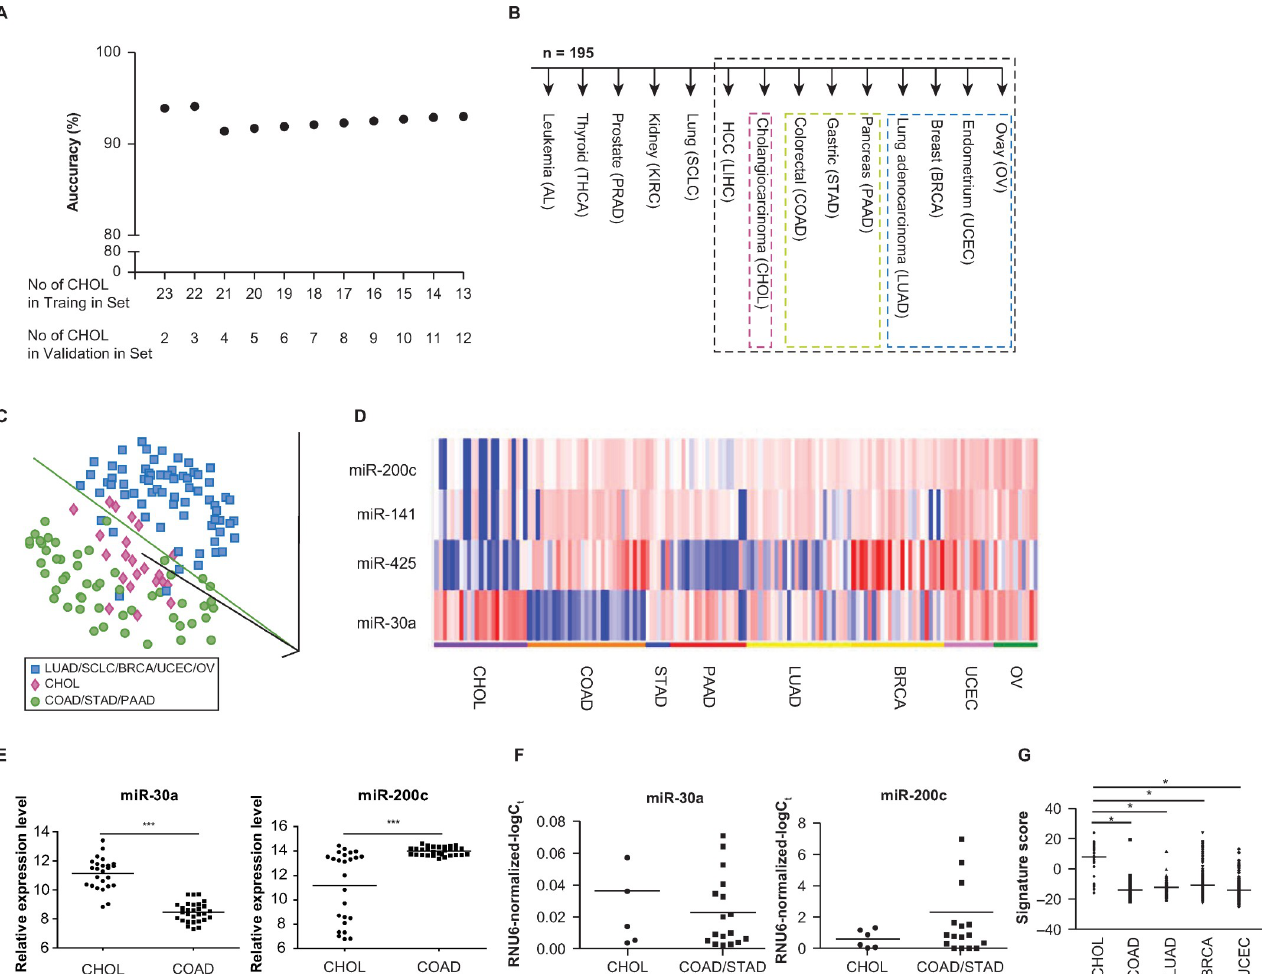
Fig 1. MicroRNAs for tissue origin. (A) Prediction accuracies of 1-NN analyses on the test set at feature selection p < 10 − 10 , after allocating different numbers of cholangiocarcinomas to the training set according to chronological order (B) Decision tree analysis. MicroRNAs that were differentially expressed at feature selection p cutoff of 0.00005 were used to predict the tissue of origin at each node of the decision tree. Samples for node no. 7 (surrounded by black broken lines) were further evaluated in Fig 1C and 1D. (C) PCA plot for samples in node no. 7 of (B), based on 914 microRNAs. Each sphere represents each sample and ‘1-correlation’ was used as a distance metric. Cholangiocarcinomas (shown in red), gastrointestinal/pancreatic cancers (shown in green), and non-digestive system cancers (shown in blue) clustered separately. (D) Expression profiles for microRNAs in node no. 7 of (B) in the training set. Expression profiles of 3 microRNAs underexpressed in cholangiocarcinomas compared with extrahepatic cancers in digestive and non-digestive systems (upper panel) and 1 overexprexpressed microRNAs (lower panel) at feature selection p < 0.00005. Since the apparent overexpression of miR-122 in cholangiocarcinomas is presumably due to contaminating hepatocytes in the sample, we decided to exclude miR-122 from a set of discriminatory microRNAs comprising the node no. 7 of the decision tree. A heatmap generated using a log2-pseudocolor image with microRNA centering. Red and blue colors denote high and low expression of microRNAs, respectively. A scale bar for the log2-expression is shown at the bottom. (E) Expression profiles of miR-30a and miR-200c between 25 intrahepatic cholangiocarcinomas (in the training and test sets) and 29 colorectal cancer metastases in the test set. Scatter plots display median microarray signal values ( ��� p < 10 − 14 and p < 10 − 5 ; t -test). (F) Real-time RT-PCR profiles of miR-30a and miR-200c in cell lines. Scatter plots display median values of RNU6-normalized–log 2 Ct values (p = 0.22 and p = 0.30, respectively; t -test). (G) Expression profiles of cholangiocarcinoma signature in TCGA small RNA sequencing data. Scatter plots display median values of normalized RPKM ( � p < 10 − 10 ;